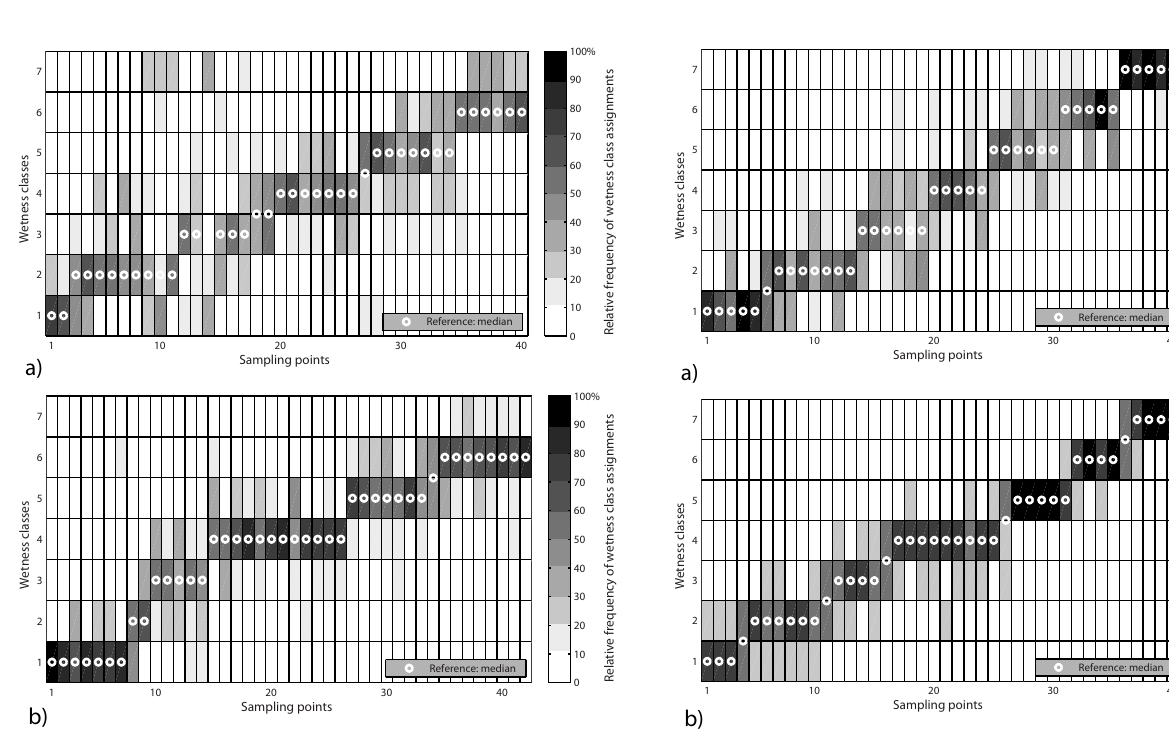
Figure 6. Spread of classification assignments for sampling points of individual wetness classes by (a) all farmers ( F all ) in April and (b) all farmers ( F all ) in June (grey shades: relative frequency of wetness class assignments for each of the sampling points, white circles: median of classifications). For example, sampling point 10 in panel (b) : the majority (56%) of raters classified this point as class 3 (white circle) but 33% of the raters assigned class 4 and 11% of the raters assigned class 2. The difference between the two graphs shows the effect of more detailed introduction and a clear assessment form. Note that during both tests, none of the sampling points were classified as class 7 by half of F all , and that the sampling points were distributed in random order of wetness classes in the field experiment, but were ordered here according to the median estimation for graphical clarity.